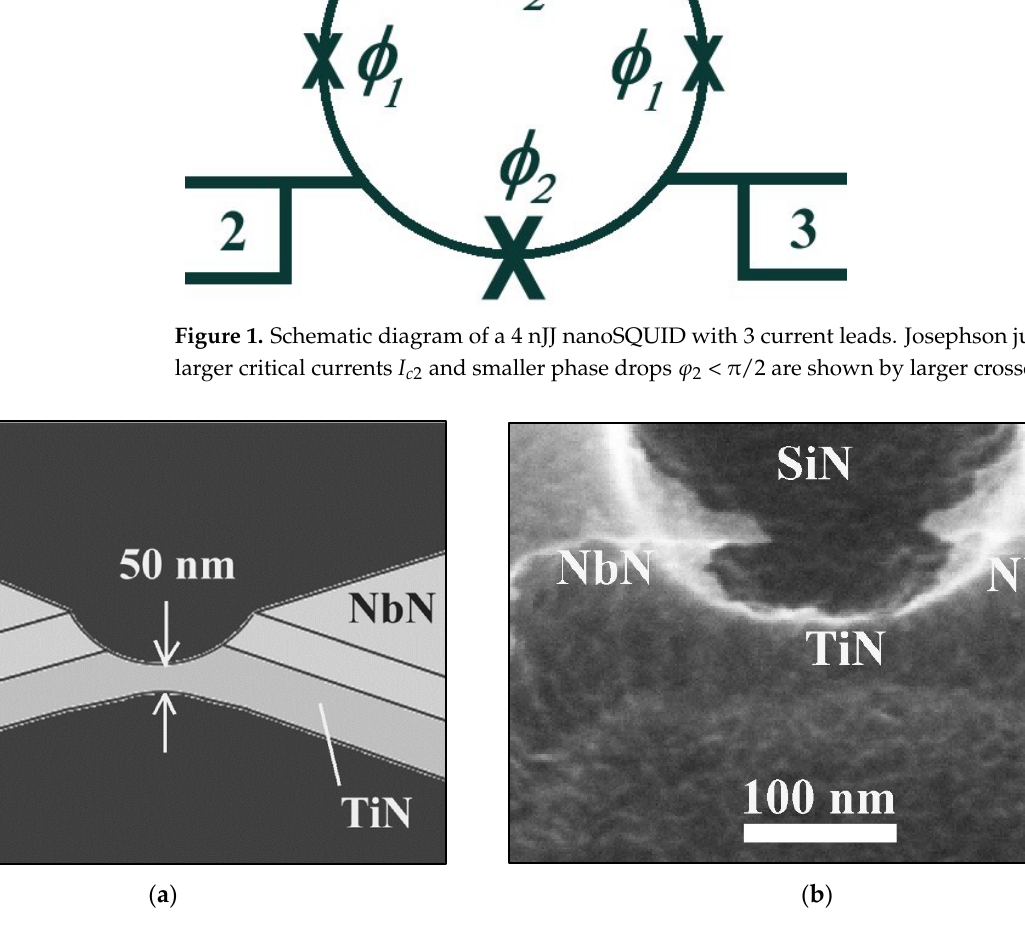
Figure 2. ( a ) Schematic view of a NbN-TiN-NbN nJJ. ( b ) SEM image of a NbN-TiN-NbN nJJ pre- pared using RIE. The image was recorded at an accelerating voltage of 15 kV and a sample tilt angle of 45°.